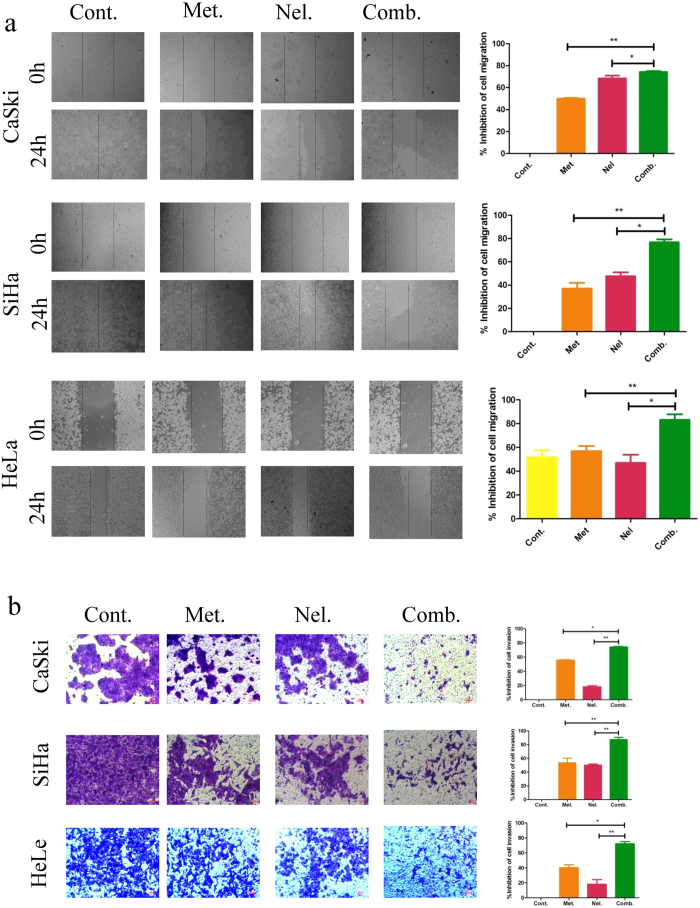
Inhibition of cell migration and invasion by metformin and nelfinavir, alone or in combination.(a) A wound-healing assay was performed to measure cell migration. SiHa, HeLa and CaSki cells were seeded in 24-well plates in the absence or presence of metformin and nelfinavir, alone or in combination, and the wound was generated by scratching the surface of the plates with a 10 μl pipette tip. Cells were then washed with PBS and incubated with metformin and nelfinavir, alone or in combination, at the indicated concentrations for 24 h. (b) For invasion assay, the invasive capacity of SiHa, HeLa and CaSki cells in the absence or presence of metformin and nelfinavir, alone or in combination, after 48hwas assessed using the Matrigel invasion chamber. Each sample was tested in triplicate and data are shown as means ± SEM. The test for synergy: *p < 0.05; **p < 0.01, compared to untreated control or individual drug (Cont, control; Met, metformin; Nel, nelfinavir; Comb, the combination of metformin and nelfinavir).